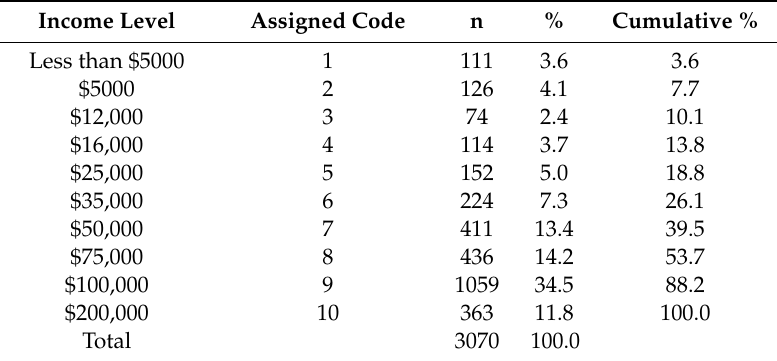
Table A1. Frequency of income in the